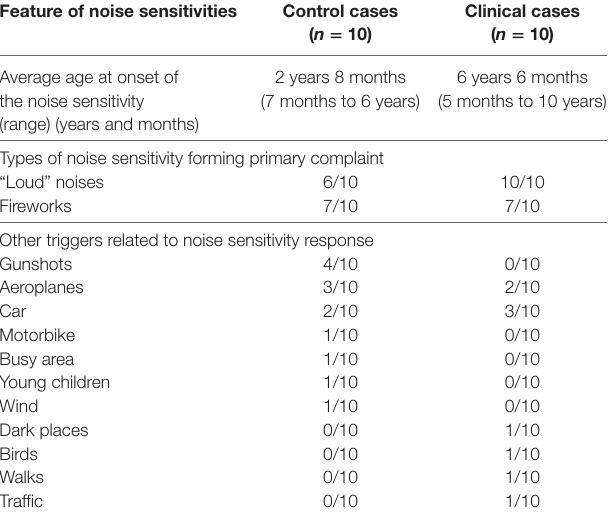
tABLe 2 | Data relating to the noise sensitivities and other related triggers in “control cases” and “clinical cases.” Feature of noise sensitivities control cases